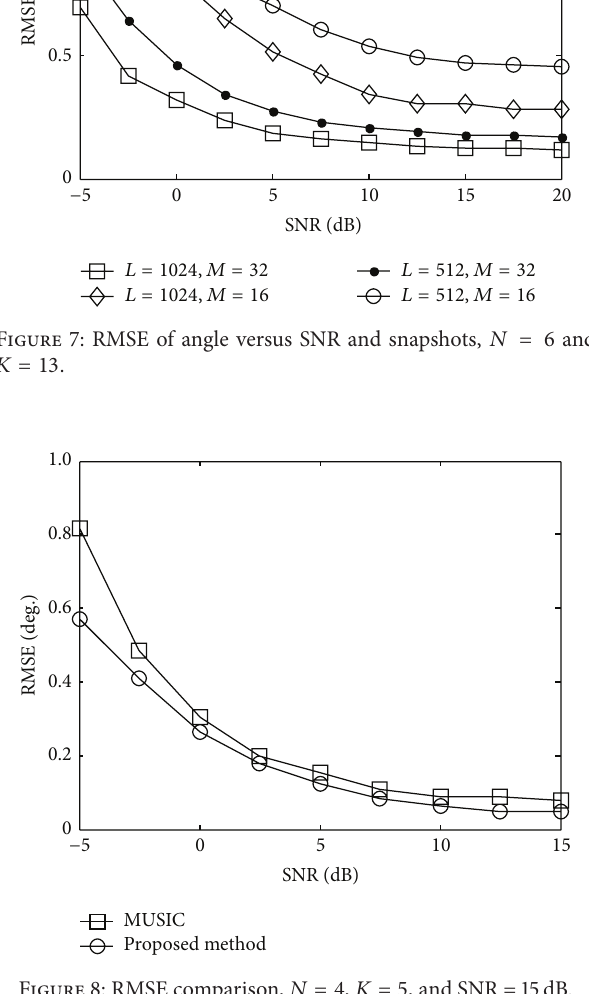
Figure 6: RMSE of angle versus frequencies, 𝑁 = 6 , 𝐾 = 3 , and SNR = 15 dB.